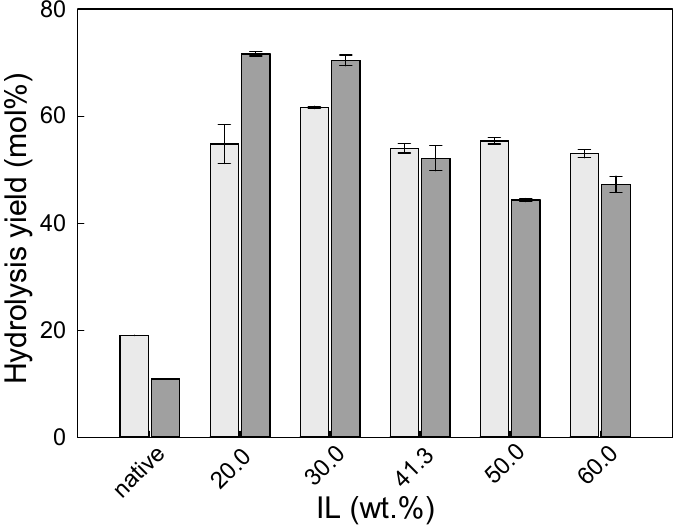
Figure 4. The enzymatic hydrolysis yield (glucan to glucose–light grey bar; and xylan to xylose–dark grey bar) of wheat straw pre-treated solids as a function of IL concentration used in the pre-treatment. The enzymatic hydrolysis yield for native wheat straw is presented for comparison.